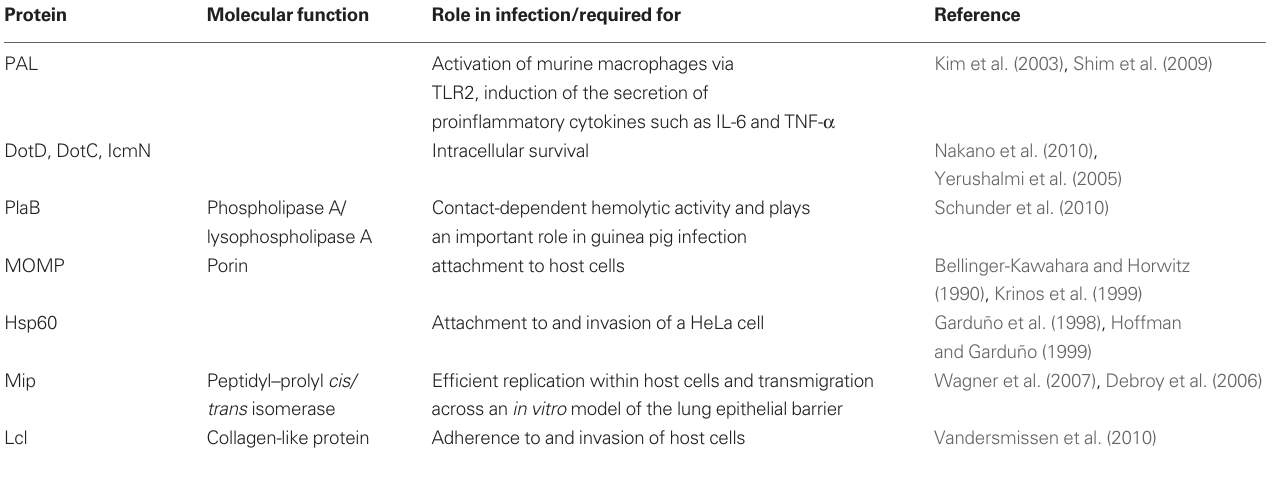
Table 3 | Outer membrane proteins of L. pneumophila associated with virulence and survival.